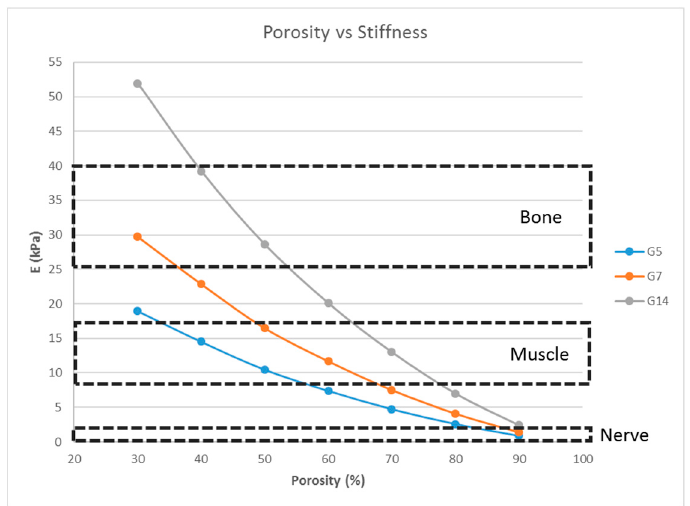
Figure 4. Effect of the porosity on the stiffness of the structure consisting of a single layer with 16 unit cells with a fixed fiber width ( d = 100 μ m) for G5, G7, and G14.